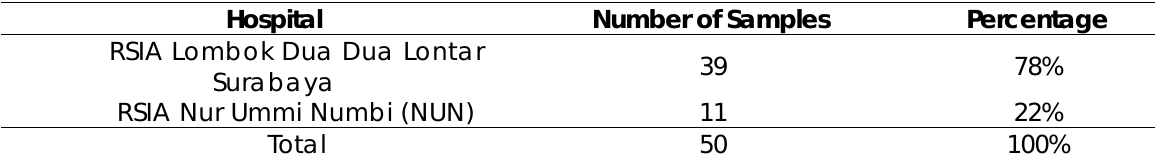
Distribution of Sample based on Data Collection Place